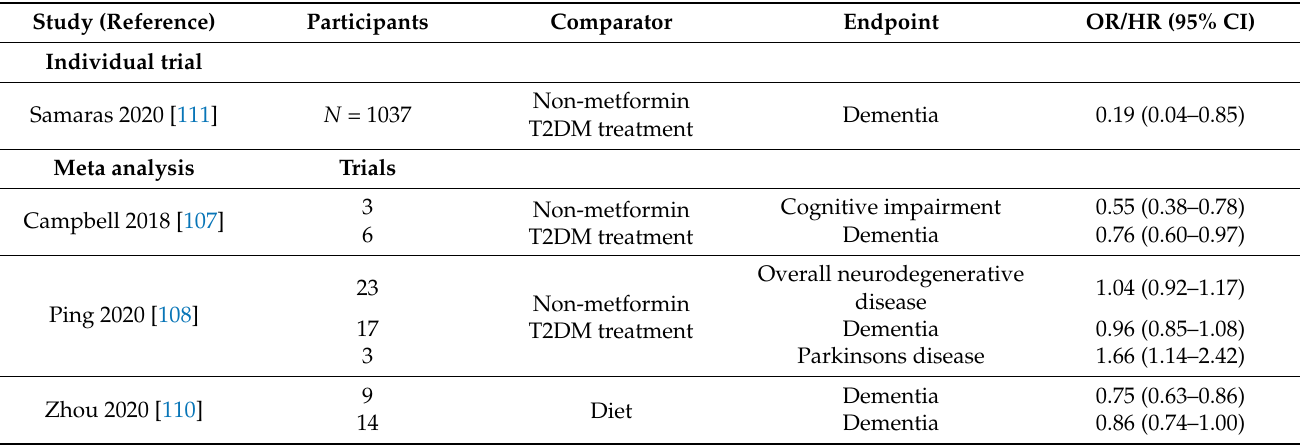
Table 5. Effect of metformin on cognitive function and